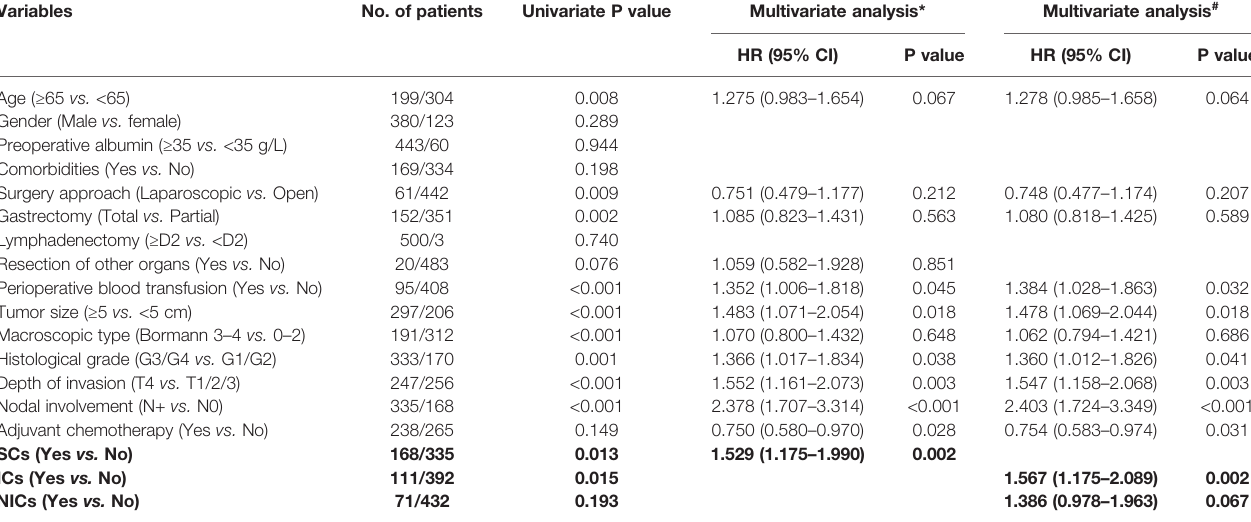
HR (95% CI) P value